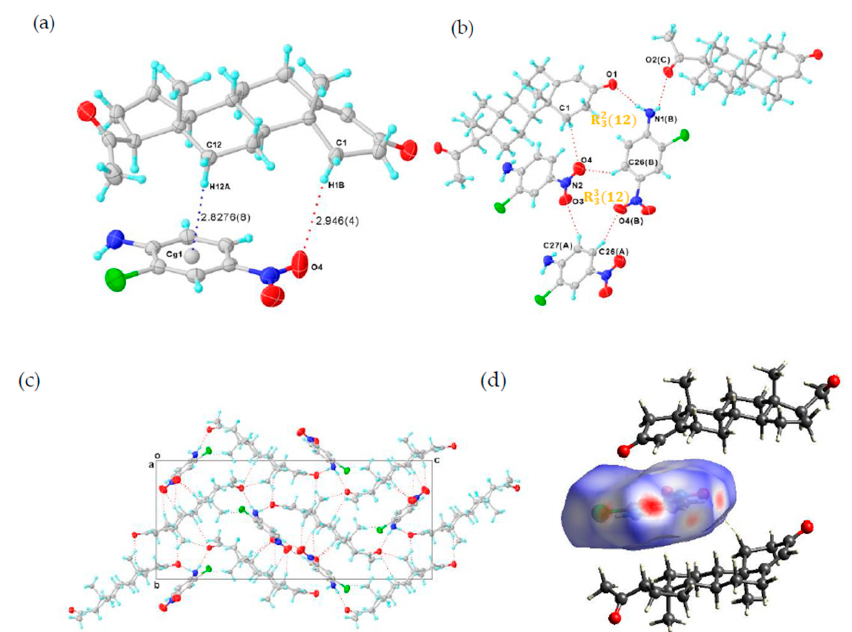
Figure 2. ( a ) Asymmetric unit of PROG-CNA, showing C-H ··· π and C-H ··· O hydrogen bonds (blue and red dashed lines). ( b ) Hydrogen-bonded pattern of PROG-CNA. ( c ) Packing diagram of PROG-CNA along the a axis. Displacement ellipsoids are drawn at 30% probability. Symmetry codes: A: − 1 + X, + Y, + Z; B: − 1 / 2 + X, 3 / 2 − Y, 1 − Z; C: 3 / 2 − X, 1 − Y, − 1 / 2 + Z. ( d ) View of the Hirshfeld surface around the CNA molecule, the surface being colored according to the electron density (e/Å 3 ).